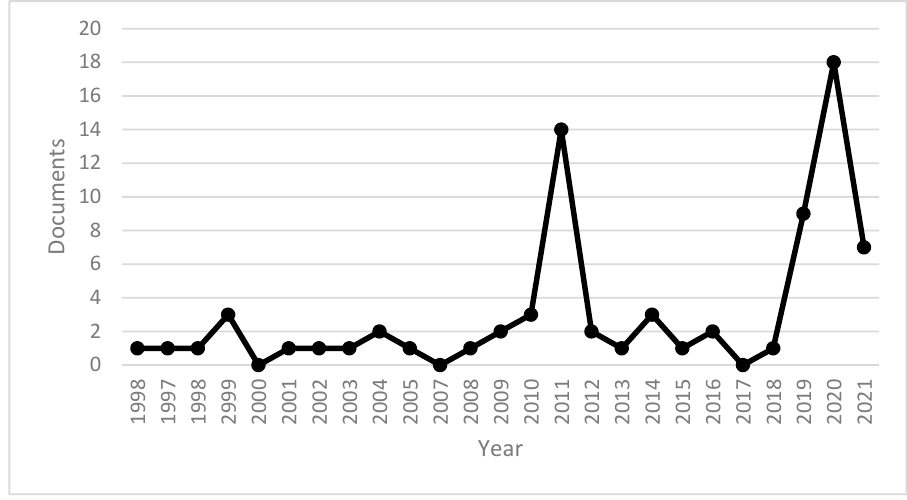
Figure 2. Number of documents by year. Source: own elaboration.